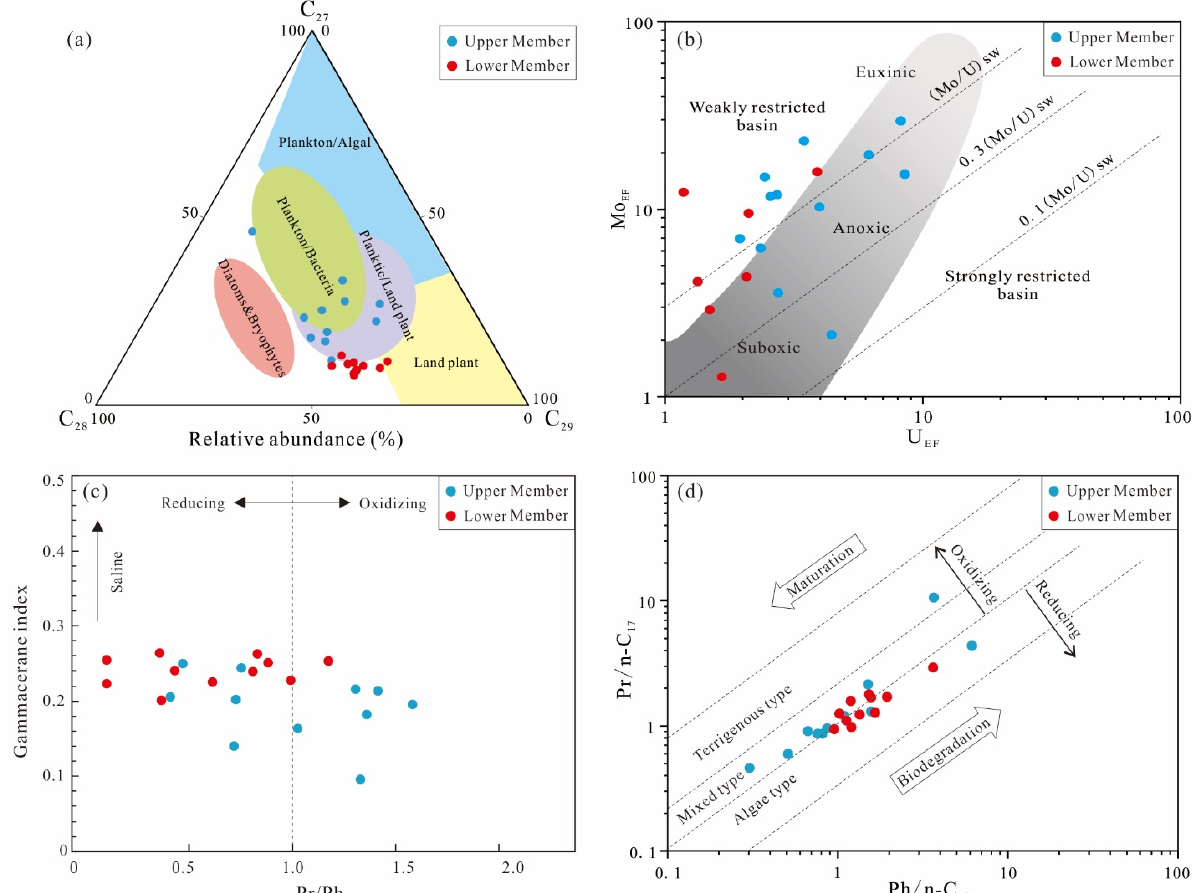
Figure 10. Paleoenvironment conditions of the ancient Permian lake indicated by trace elements and biomarkers. ( a ) Ternary plot of C 27 –C 28 –C 29 regular steranes, illustrating the organic matter input (modified from [73]). ( b ) Plot of U EF versus Mo EF. The diagonal lines represent multiples (0.1, 0.3 and 1) of the Mo:U ratio of present-day seawater (modified from [74]). ( c ) Plot of Pr/Ph versus the Gammacerane index. ( d ) Plot of Ph/nC18 versus Pr/nC17 (following [75]).